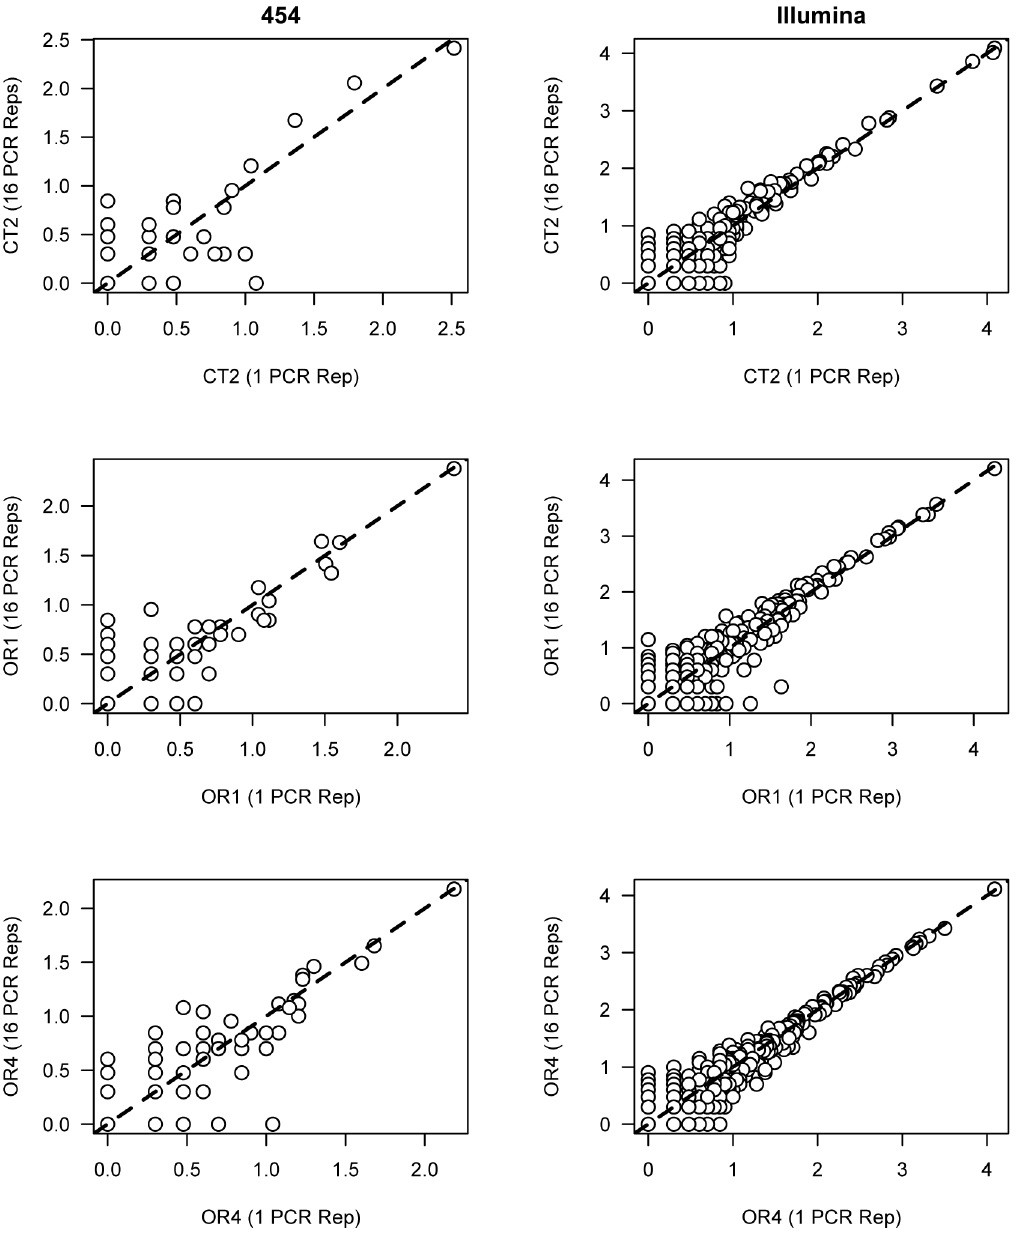
Figure 2. Taxon abundance is strongly correlated across sequencing runs with different levels of PCR replication. Circles represent individual taxa, and the relationship between the log 10 of their abundance in samples comprised of 16 PCR replicates (y axis) and one PCR replicate (x axis) for CT2 (top two panels), OR1 (middle two panels), and OR4 (bottom two panels). Dashed lines represent a 1:1 relationship. The left three panels show samples sequenced with 454 and the right three panels show samples sequenced with Illumina